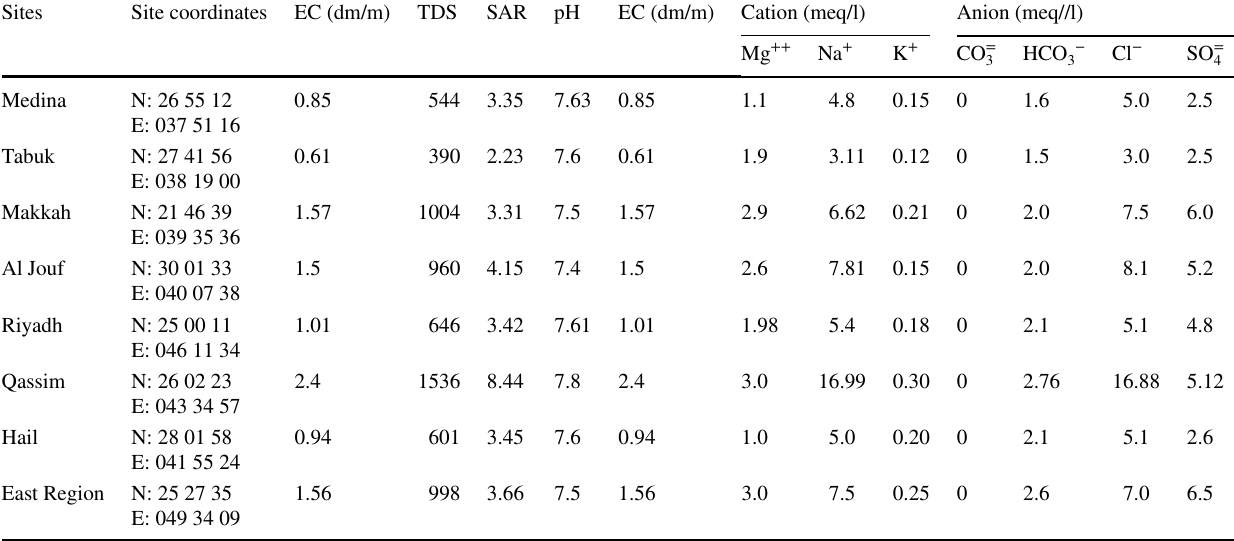
Table 2 The analyses of the irrigation water